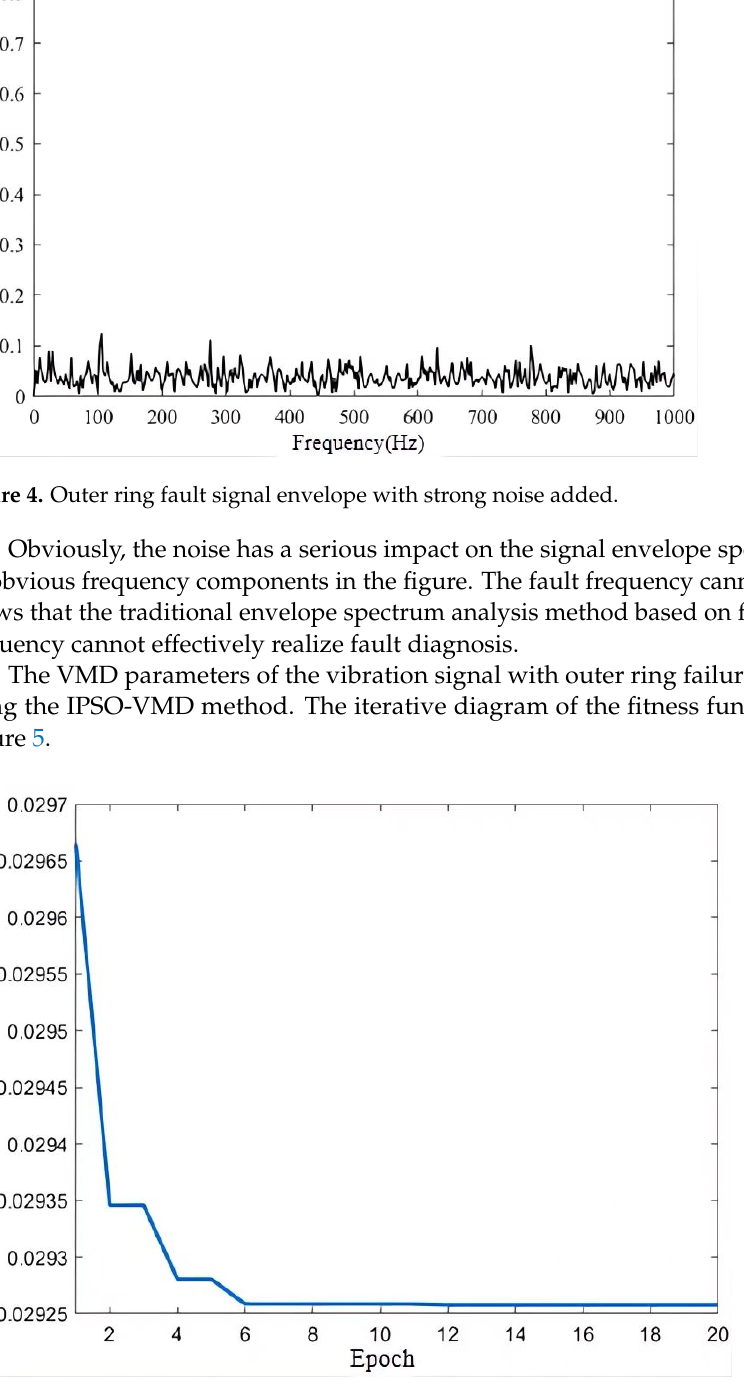
Figure 3. Time Domain Diagram of Outer Ring Fault Signal with Strong Noise.